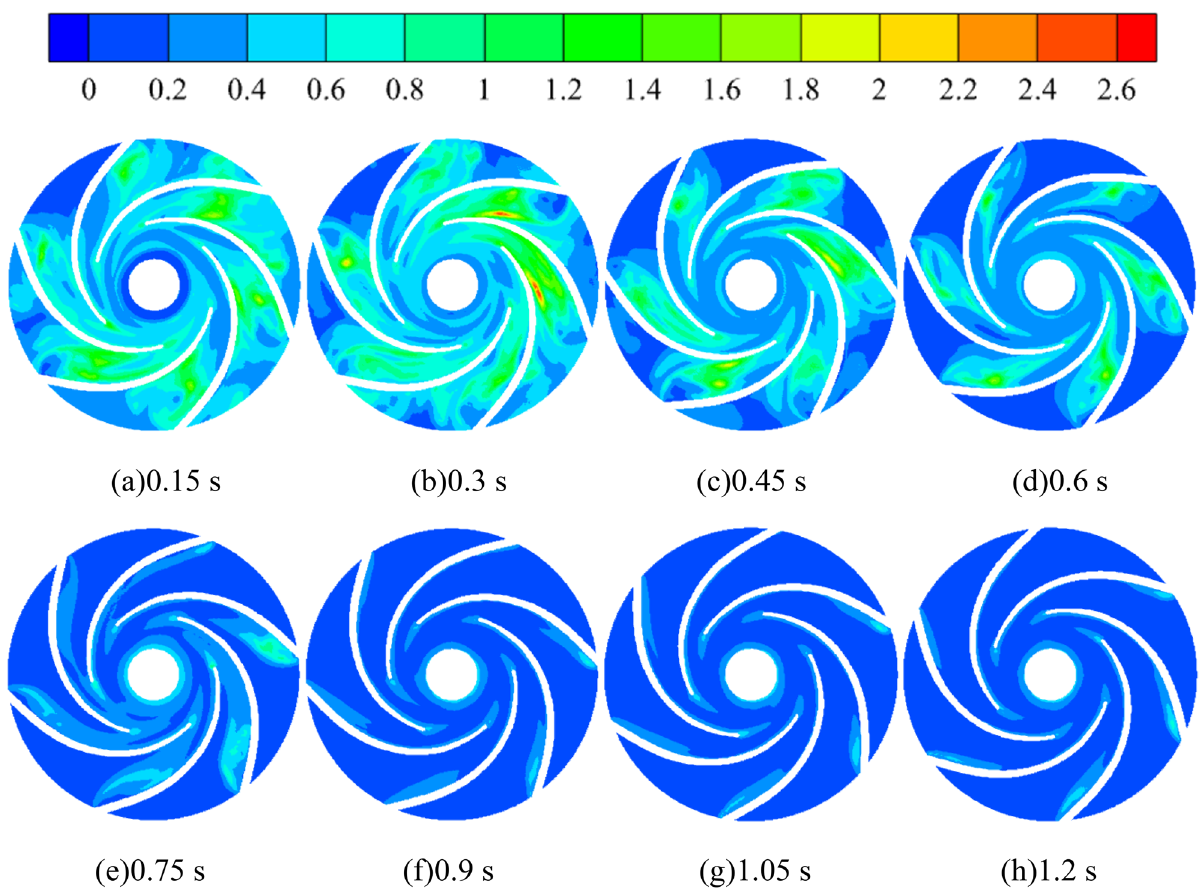
Figure 11. Turbulent kinetic energy distribution of impeller runner section during medium-speed start-up (m 2 /s 2 as turbine reaches a stable value of 1.689 kW; at 0.9 s of the calculation process, the medium-speed starting pump as turbine reaches a stable value of 1.694 kW; at 1.4 s of the calculation process, the slow-starting pump as turbine reaches a stable value of 1.697 kW. It can be found that the pump as turbine impeller speed reaches the stable value at 0.4 s, 0.9 s and 1.4 s for rapid, medium and slow start accelerations, respectively, while the instantaneous shaft power of the pump as turbine reaches the stable value at the same time as above. In the rapid, medium and slow starting conditions, the instantaneous static pressure curves at the pump as turbine inlet and outlet are shown in Fig. 10. Figure 10a shows the instantaneous static pressure at the turbine inlet. It can be found that the instantaneous static pressure curves at the pump as turbine inlet under different starting acceleration basically overlap, which is because the pressure at the turbine inlet is determined by the pressure at the outlet of the booster pump, so the effect of the rotation of the pump as turbine impeller on its inlet pressure is almost non-existent. At the beginning of the calculation process, the pressure at the inlet of the pump as turbine showed a general trend of fluctuating up and down first, then rising rapidly and finally falling slowly to a stable value. The pressure at the pump as turbine inlet fluctuates sharply until 0.03 s, then reaches a local extreme value of 237.861 kPa at 0.209 s, and finally reaches a stable value of 233.259 kPa at 0.31 s. It can be seen that the pump as turbine inlet pressure is not related to its impeller rotation speed, and there is a slight pressure shock phenomenon during the start-up process. Figure 10b shows the instantaneous static pressure curves at the outlet of the pump as turbine, unlike the inlet static pressure, the outlet static pressure shows a relatively complex trend, and all three curves show a trend of first falling and then rising to a stable value. In the calculation process of 0.017 s, 0.092 s and 0.167 s, there are obvious extreme value points, the value of 146.646 kPa, 101.581 kPa and 41.926 kPa respectively. 0.3 s after the calculation process, the pump turbine starts to start, and the impeller speed rises continuously. Due to the different starting accelerations of the pump as turbine impeller, the three outlet static pressure curves show dif- ferent rising characteristics. In the rapid start-up process, the pump as turbine outlet static pressure reached a stable value of 52.983 kPa at 0.524 s. Before that, the pump as turbine outlet static pressure showed a fluctuating rising trend; the time required for the outlet static pressure to rise to the stable value showed a slight tendency to extend compared with the rising impeller speed of the pump as turbine. During the medium speed start-up, the pump as turbine outlet static pressure reaches a stable value of 53.321 kPa at 0.979 s. During the slow speed start-up, the pump as turbine outlet static pressure reaches a stable value of 55.391 kPa at 1.444 s. Thus, it can be seen that the time required for the pump as turbine outlet static pressure to reach a stable value has a slight